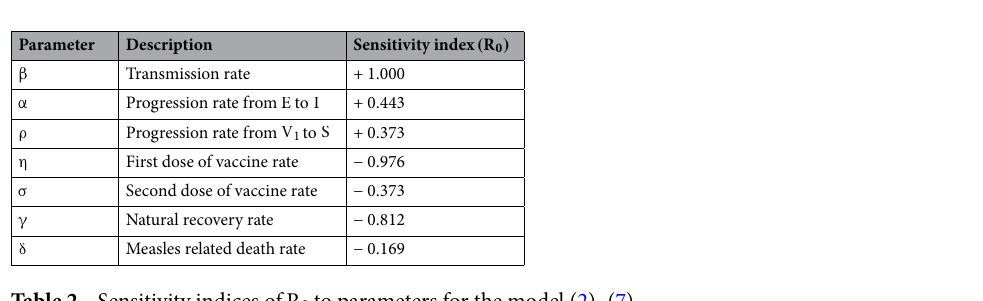
Table 2. Sensitivity indices of R 0 to parameters for the model